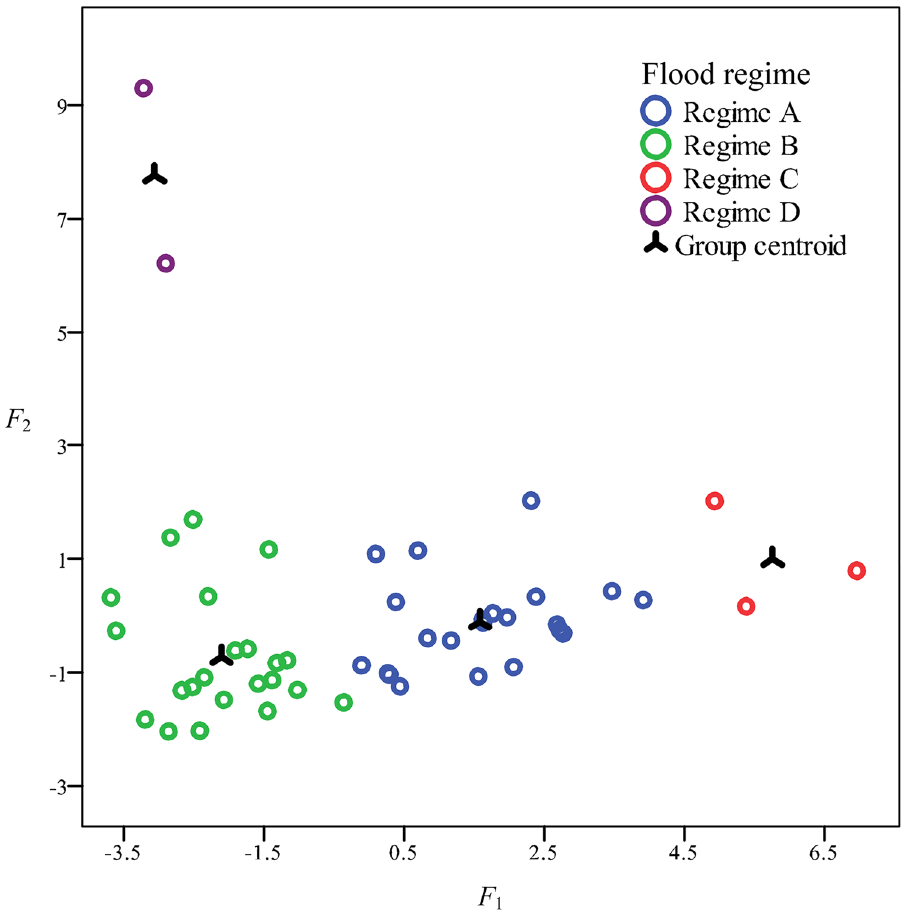
Figure 2. Discriminant analysis of different flood regimes in 1961–1969. F 1 and F 2 represent the scores of discriminant functions. Regime A: short flood duration and low erosive energy; Regime B: short flood duration and high erosive energy; Regime C: long flood duration and low erosive energy; Regime D: long flood duration and high erosive